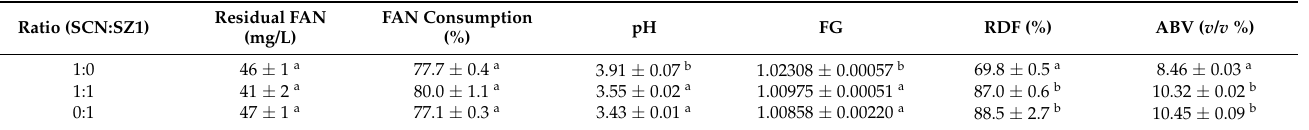
Table 5. Fermented wort characteristics of S. cerevisiae (SCN) and S. pombe (SZ1) monocultures,